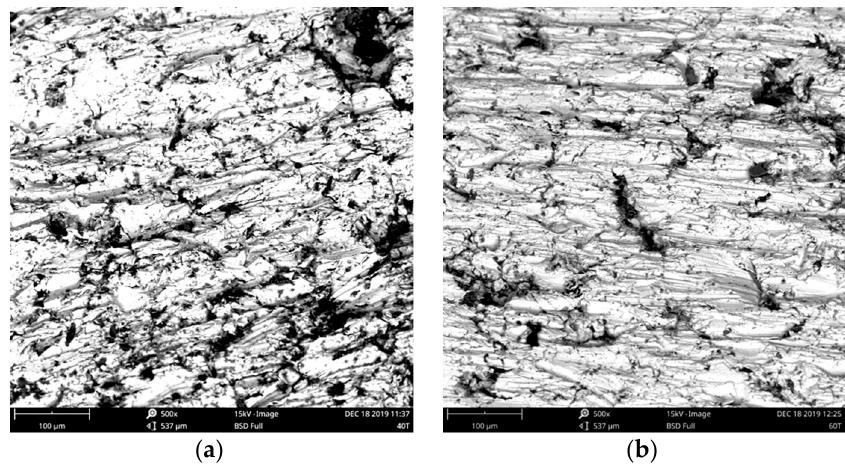
Figure 5. Cross-section microstructure photographs ( a ) for compaction pressure 310 MPa, ( b ) for compaction pressure 470 MPa.